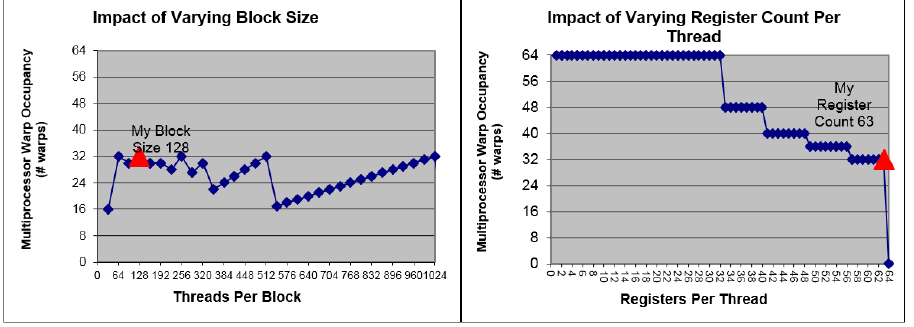
Figure 10. Results of occupancy calculations. ( Left ) Impact of varying block size on occupancy; ( Right ) Impact of varying register count per thread on occupancy.